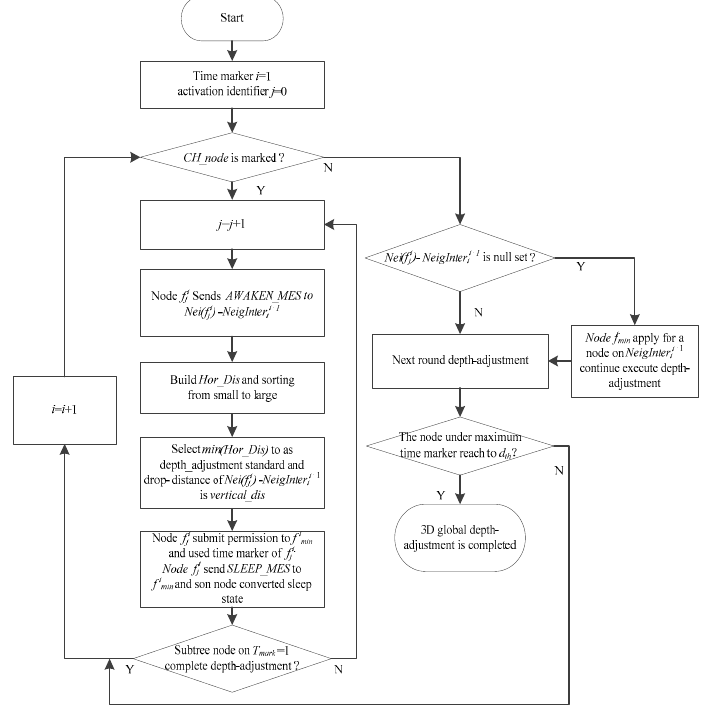
Figure 8. Flowchart of the depth-adjustment strategy.